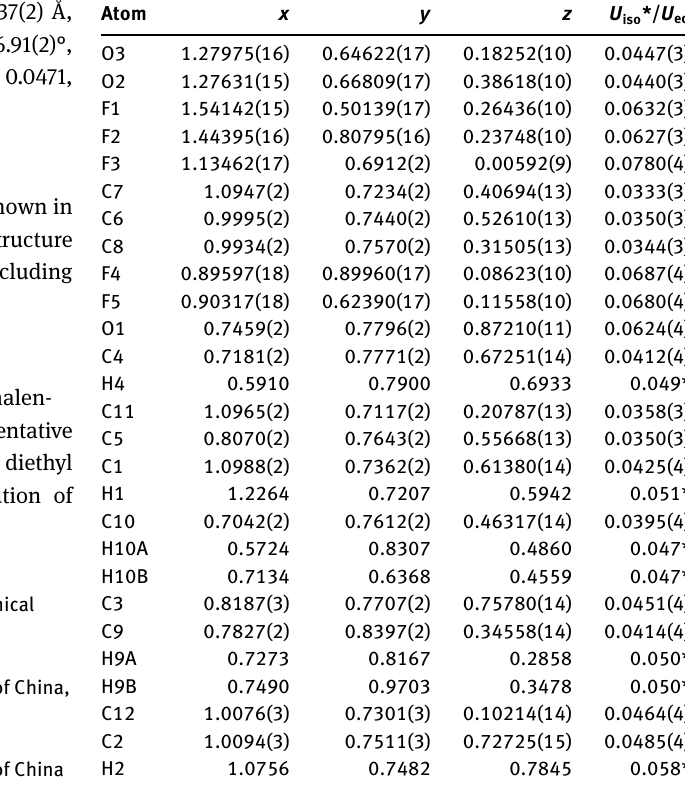
Table 2: Fractional atomic coordinates and isotropic or equivalent isotropic displacement parameters (Å 2